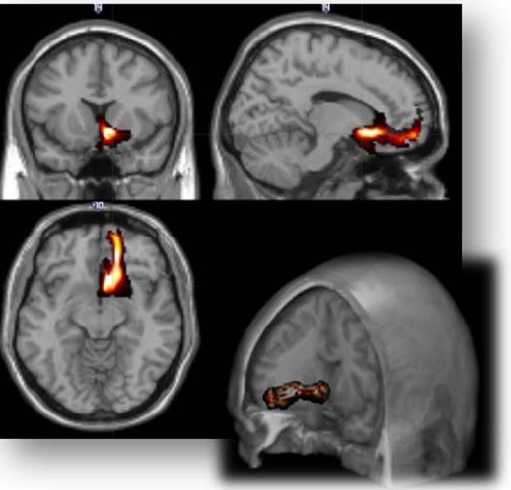
Figure 1. Three-dimensional representation of the average distribution of the connection patterns between the right amygdala and the ipsilateral dorsal anterior insular cortex.